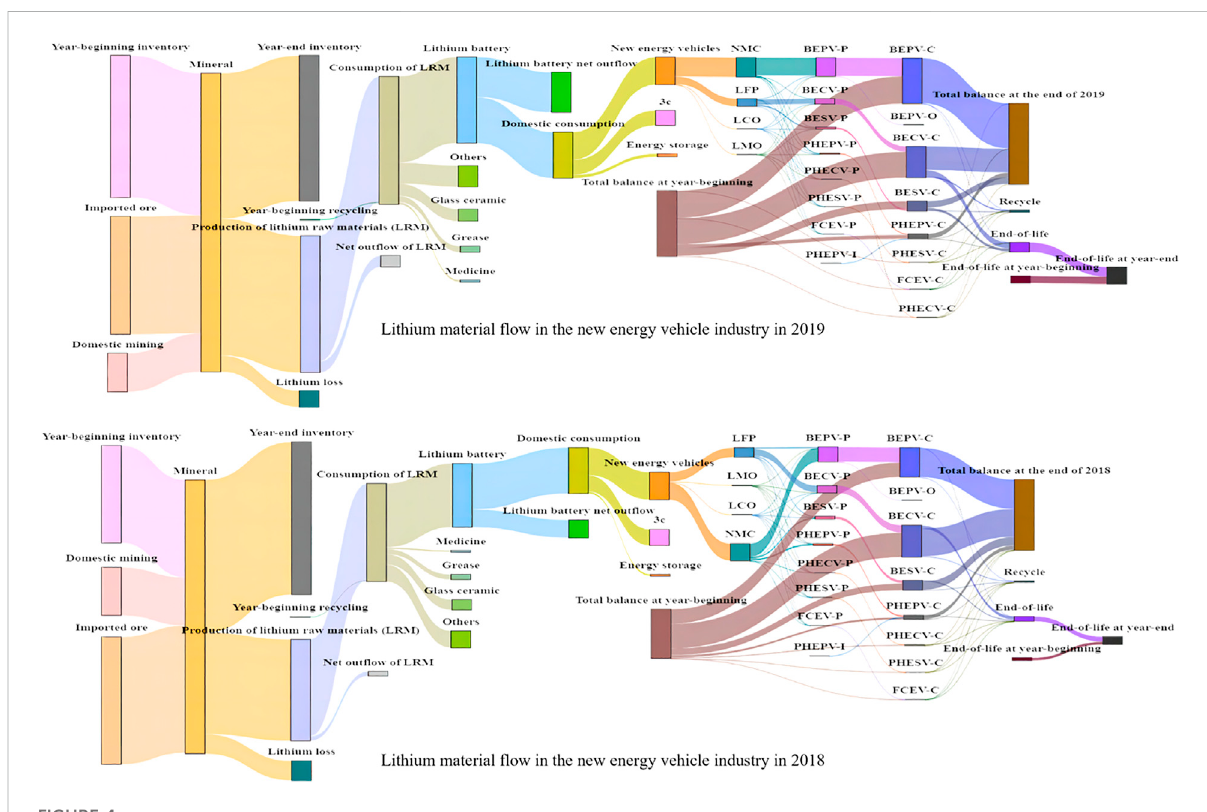
FIGURE 4 Lithium material fl ow in the new energy vehicle industry in 2018 –